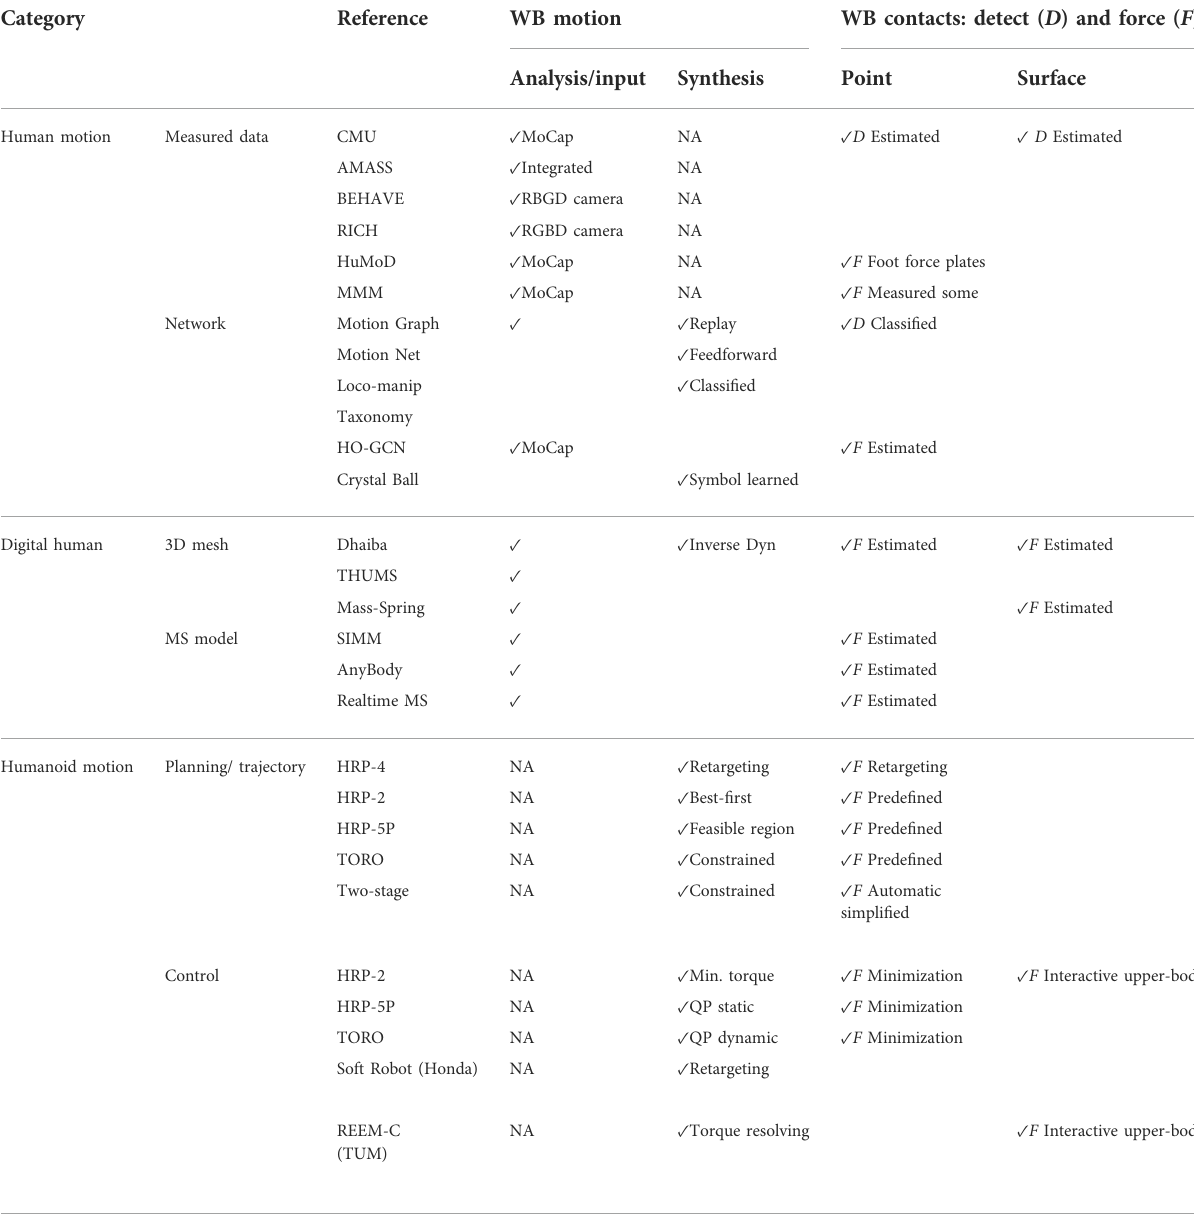
TABLE 1 Related works on contact-rich whole-body motions by cyber-physical humans. The mark “ NA ” means the item is not applicable to the category.